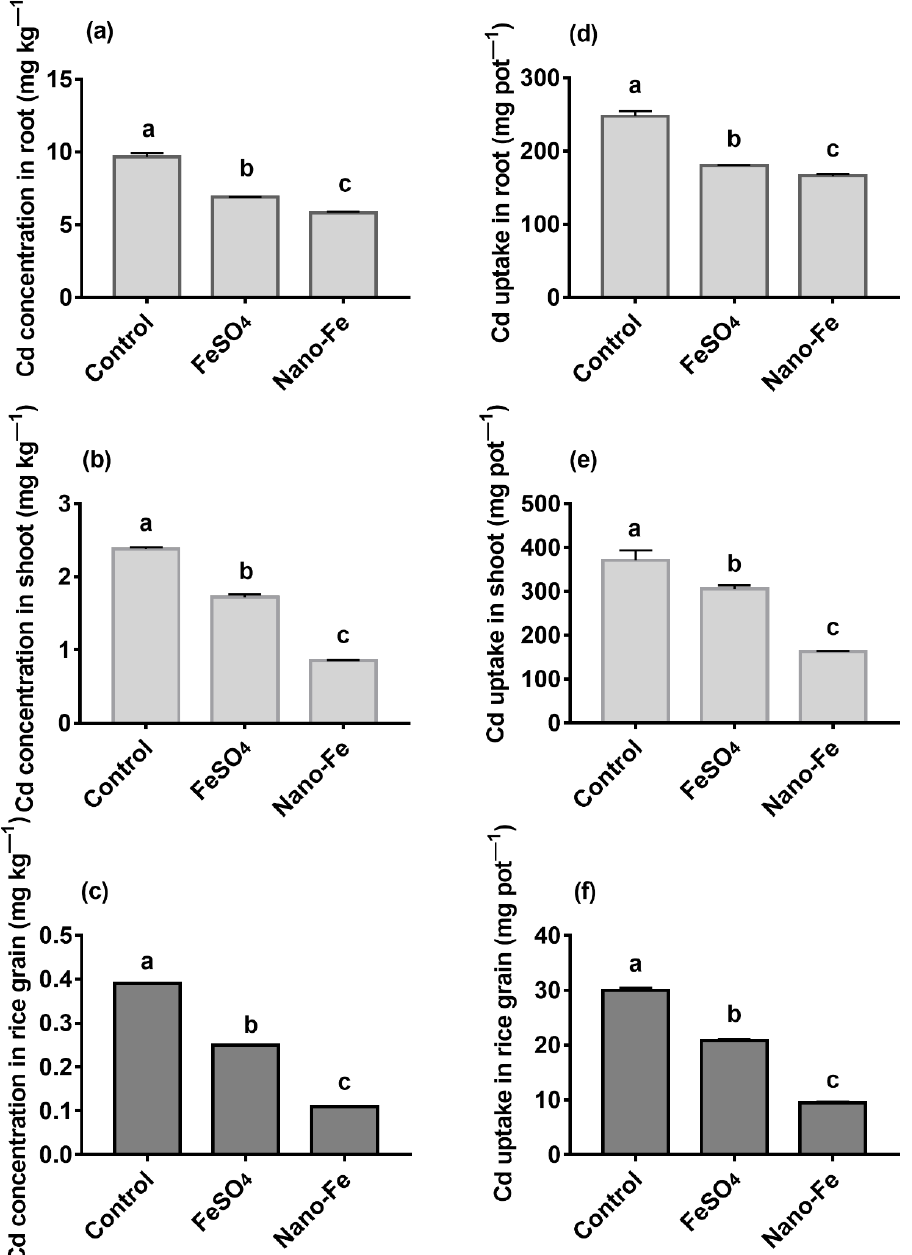
Figure 2. Concentrations of Cd in the roots ( a ), shoots ( b ), grains ( c ) of rice and uptake of Cd in the roots ( d ), shoots ( e ), grains ( f ) of rice derived from treatments with exogenous Fe applied as FeSO 4 or Nano-Fe. Different lowercase letters in the columns indicate a significant difference among the different treatments at p < 0.05 .